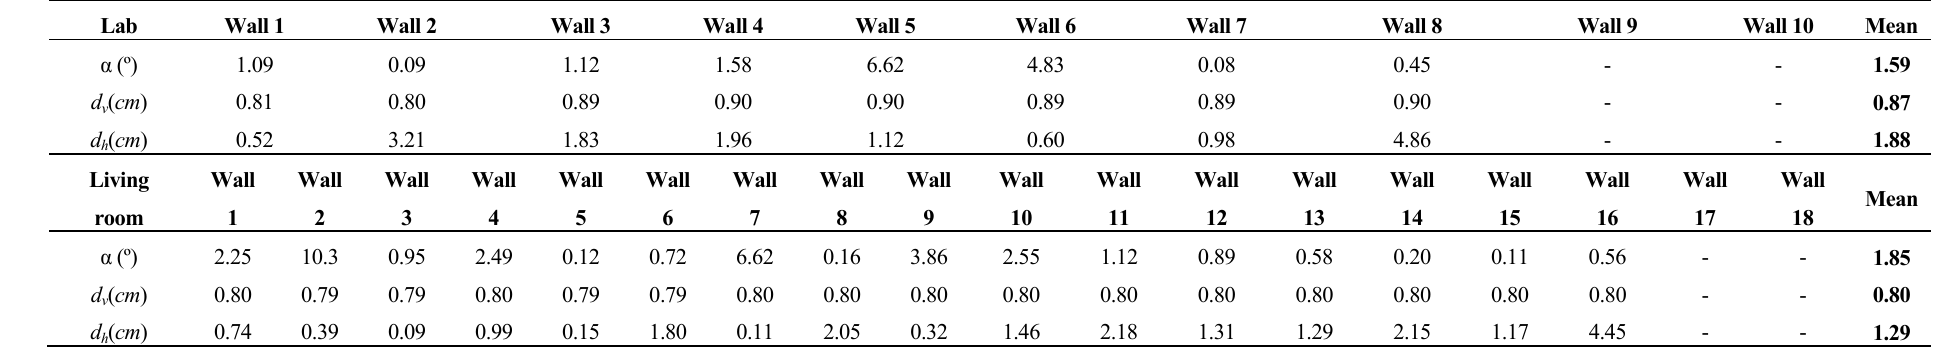
Table 2. Parameters calculated for each pair of